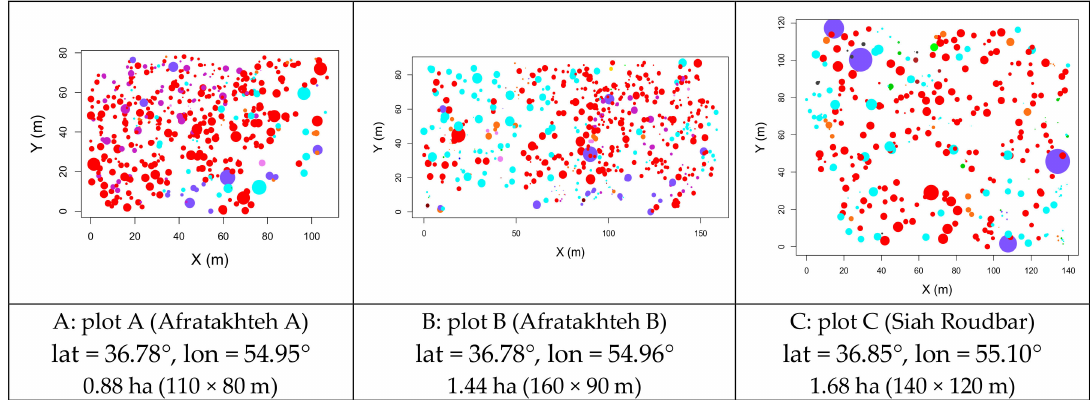
Figure 3. The three plot maps ( A : Afratakhteh A, B : Afratakhteh B and C : Siah Roudbar) with the latitude (lat) and longitude (lon) of the plot centers, plot dimensions, and total areas; the most abundant tree species is Taxus baccata shown in the red color. Other prominent species are Carpinus betulus (light blue), Carpinus schuschaensis H. Winkl. (violet), Tilia rubra DC. (bisque), Acer laetum C. A. Meyer (chocolate), and Quercus castaneifolia